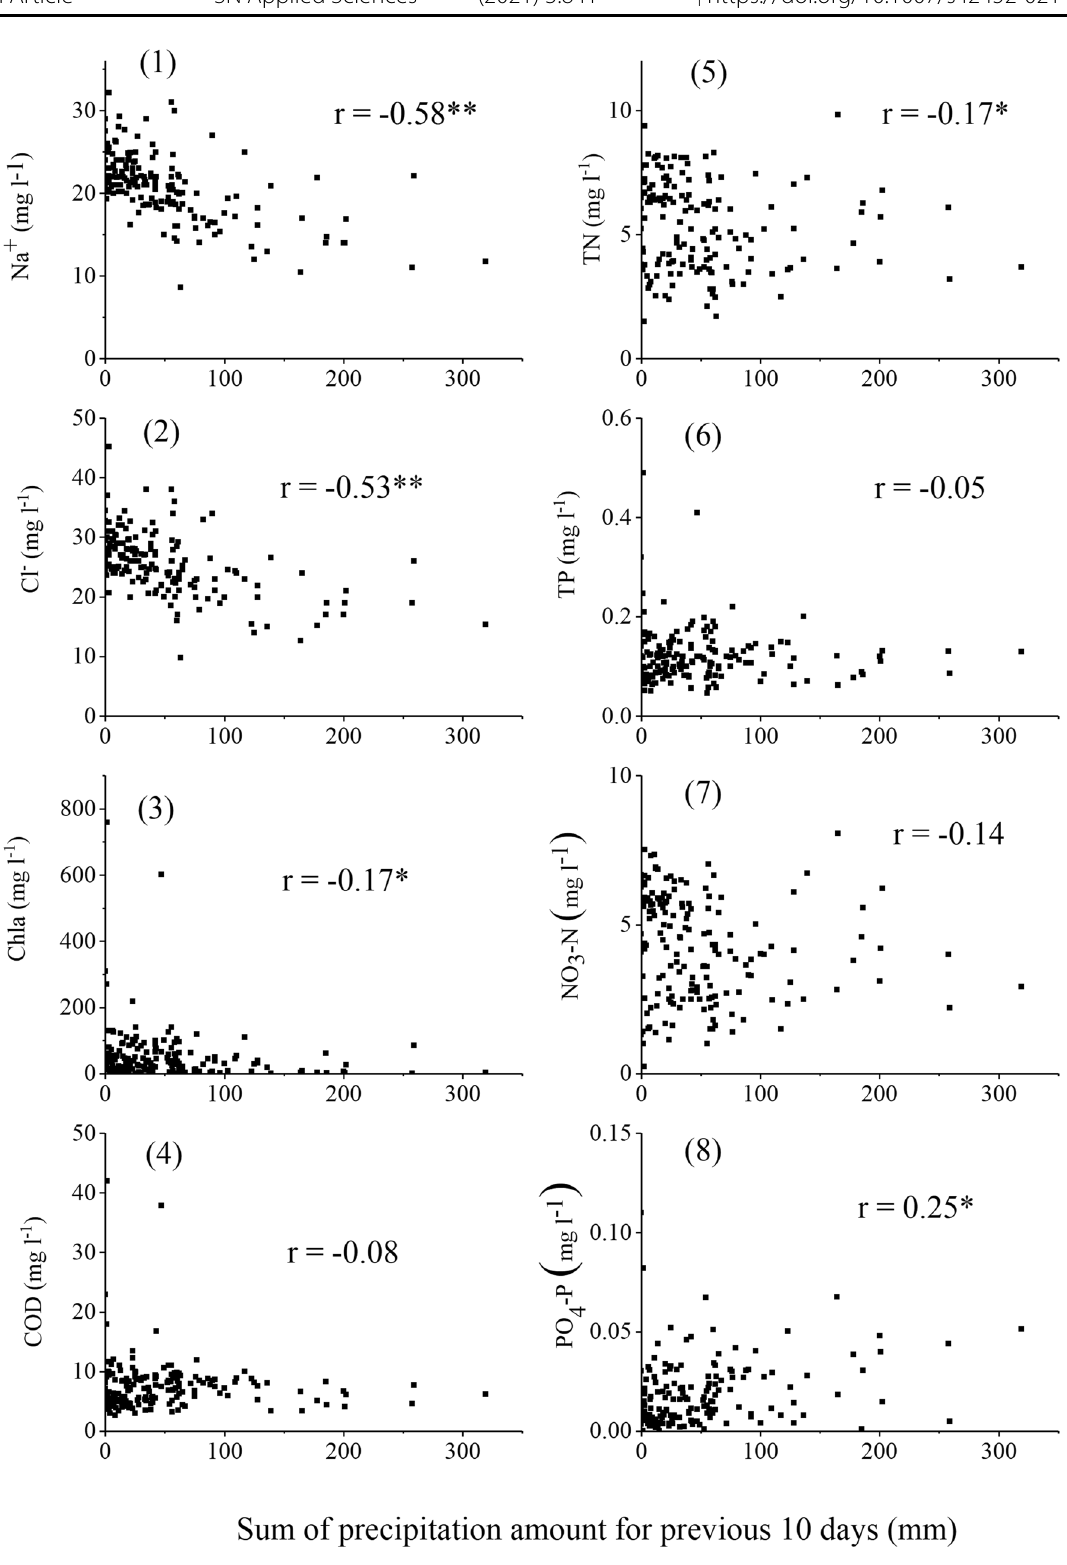
Fig. 2 The relationships between the sum of the precipitation amounts for 10 days prior to water sampling and the water-quality indicators at St. 3. (1) Na + , (2) Cl − , (3) Chla, (4) COD, (5) TN, (6) TP, (7) NO